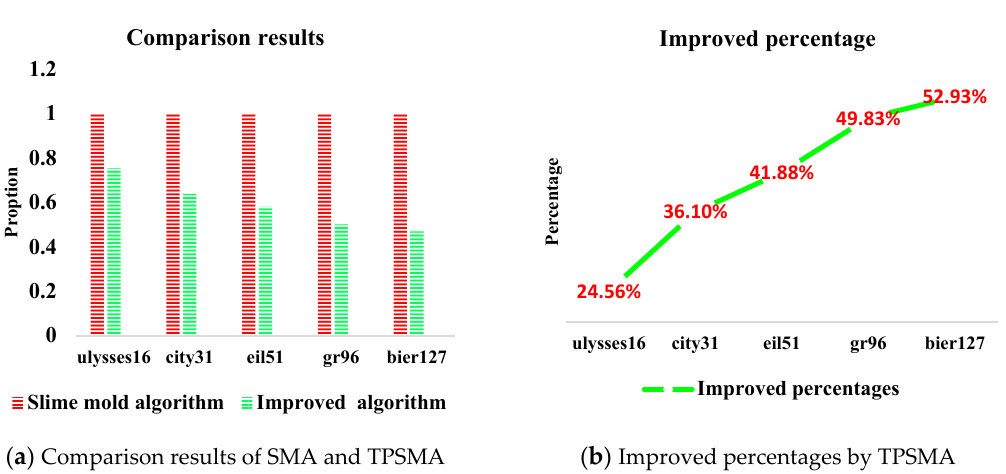
Figure 13. Analysis results of SMA and TPSMA under the four sets of data.